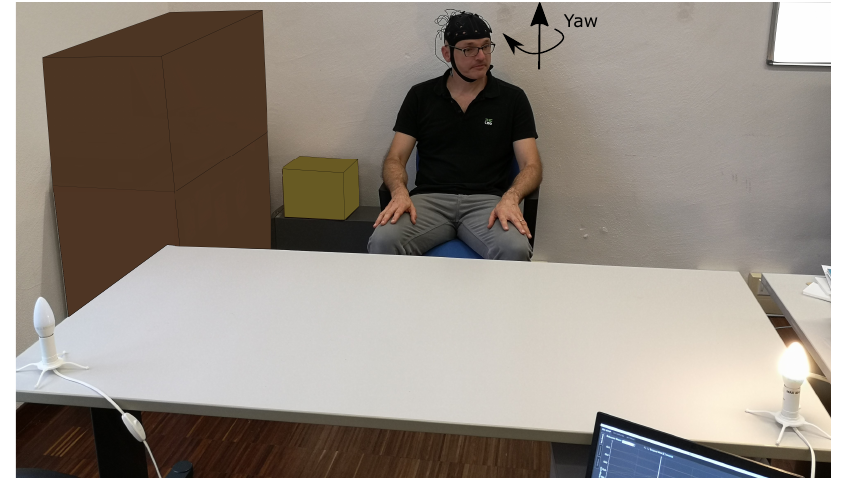
Figure 2. Top vision of the layout for the experimental set